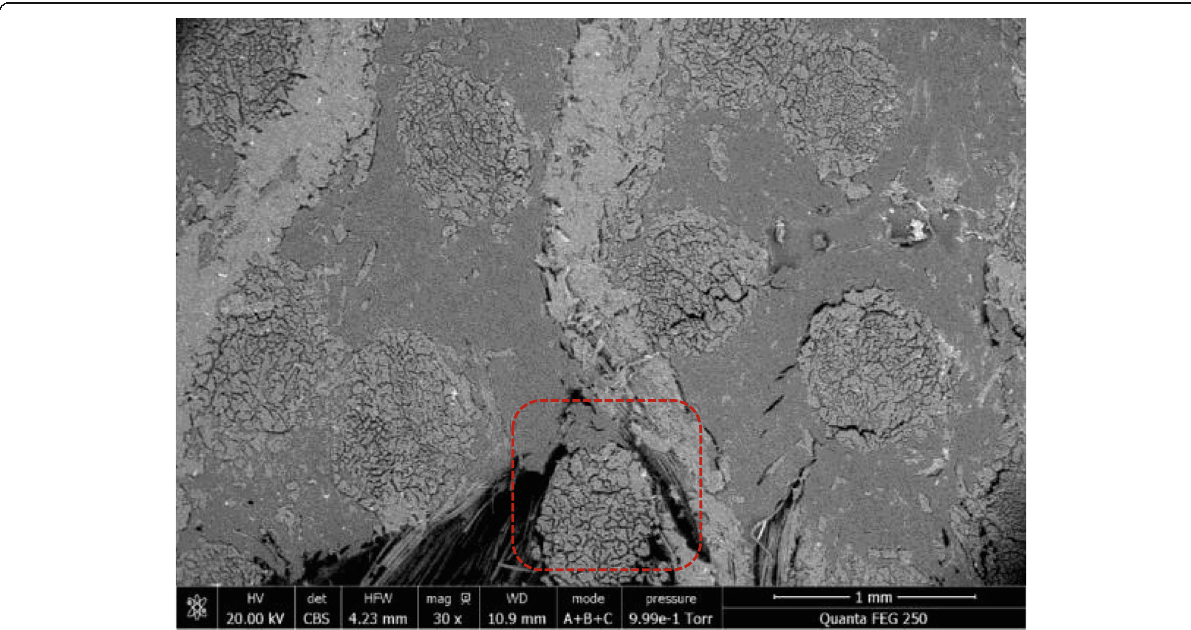
Fig. 8 Observation of crack propagation around a stitch using SEM